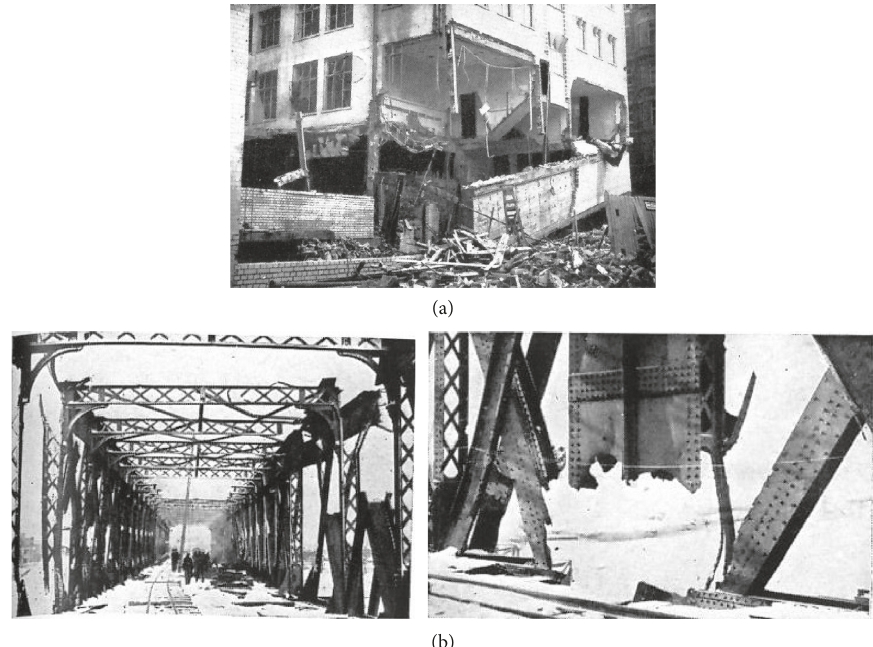
Figure 3: Examples of changes in structural system after local damage during extreme event (bombings during WWII): (a) seven-storey steel-framed office building reported by [37] after the main plate girder was blown down by a direct hit; (b) damage over the Oissel Bridge over the Seine reported in [38] (photographs used with the permission of the Institution of Civil Engineers,